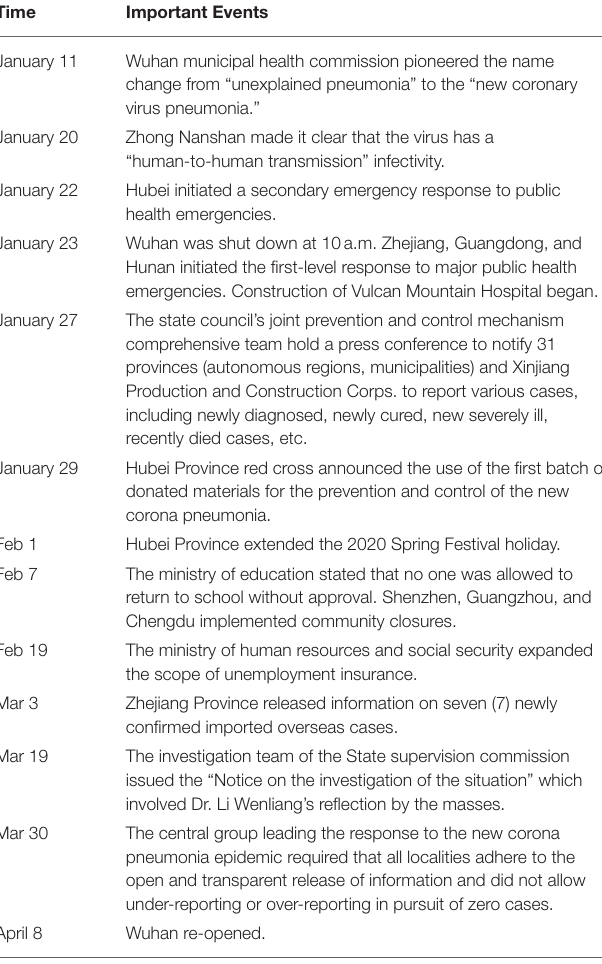
TABLE 1 | Inclusive timeframes of news events during COVID-19. TABLE 2 | Top 20 government media Weibo accounts with the highest number of information